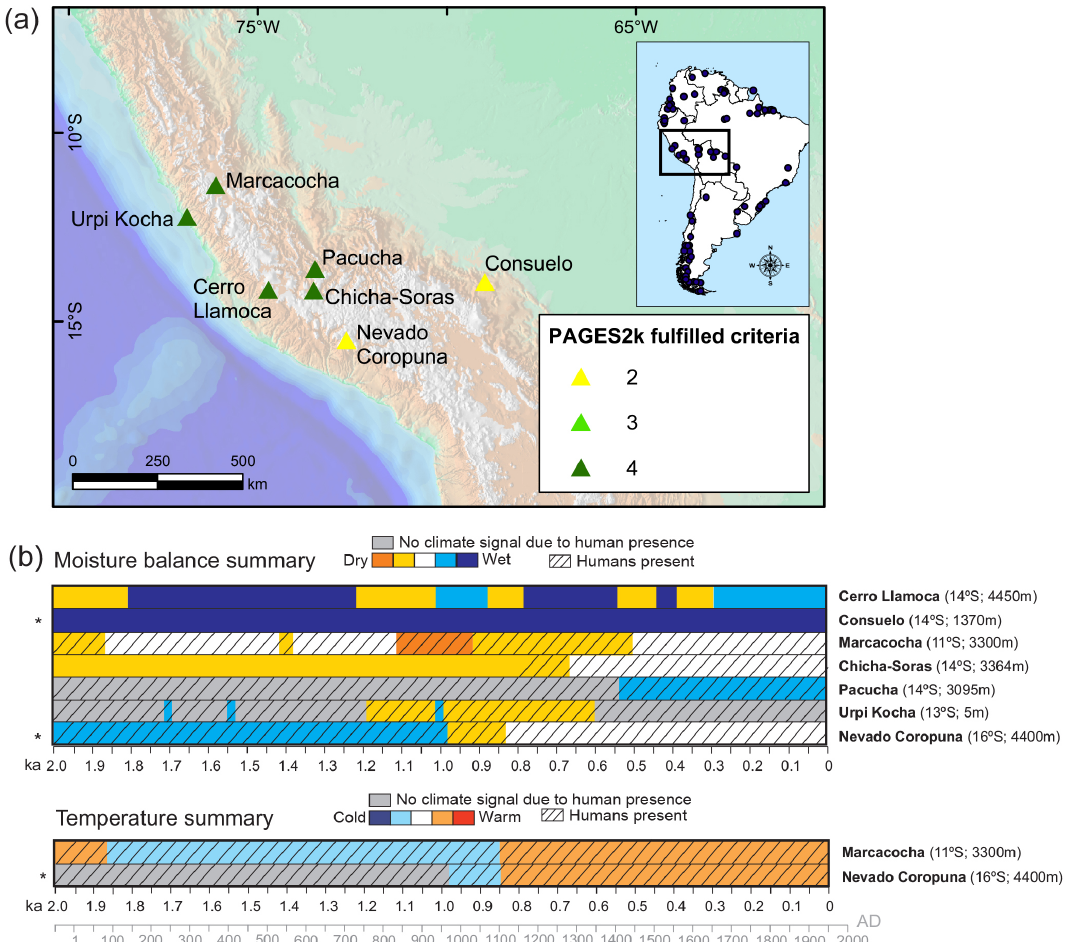
Figure 9. Panel (a) : map showing the pollen records discussed in the Central Andes and the number of PAGES-2k criteria these records fulfill. Panel (b) : summary of moisture balance and temperature including human interference for the pollen records discussed. Not all records are suitable to derive both a moisture and a temperature signal. Climate and human presence are shown overlapping when the pollen record is not conclusive regarding the derived signal. Bars are shaded grey when the climate signal is obscured by human interference. Records fulfilling one or two criteria indicated by